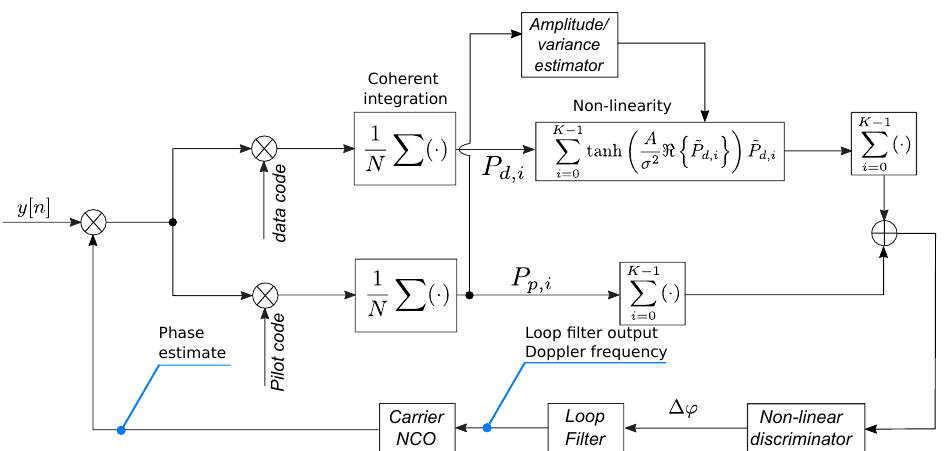
Figure 1. Schematic representation of a PLL integrating the LNL correlator and fully exploiting the availability of data and pilot